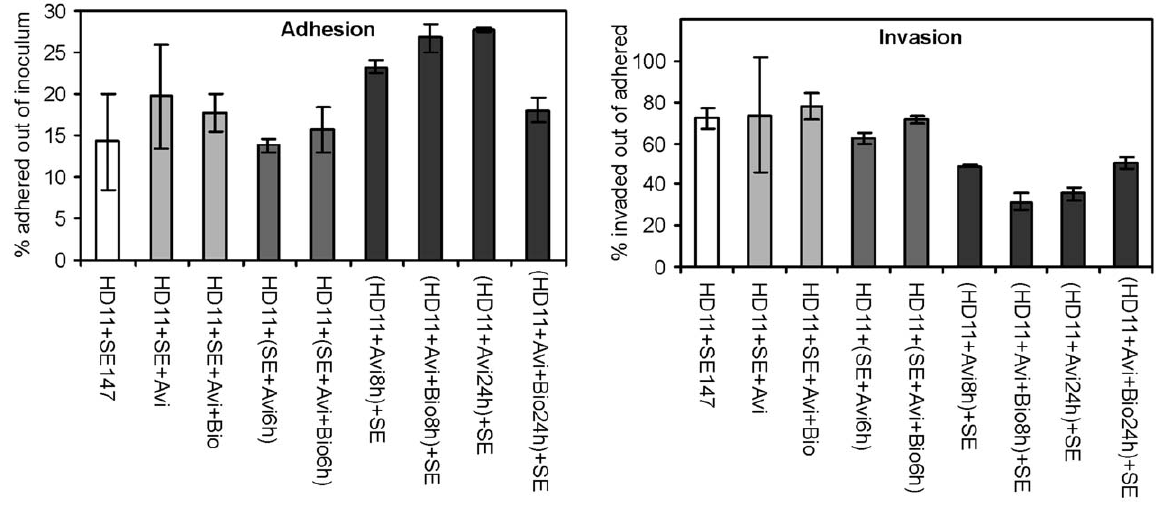
Figure 5. Influence of avidin and biotin on the ability of S . Enteritidis to adhere to and invade the HD11 chicken macrophage-like cell line. Parentheses indicate whether the pretreatment with avidin and/or biotin was done on the HD11 cell line or S . Enteritidis. Grey scaling is used to simplify individual group differentiation. When the group of all avidin treated HD11 cells was compared with all the remaining experiments in which the cell culture was not pretreated, the comparison came out as significantly different by a t-test with p , 0.05, both in adhesion and